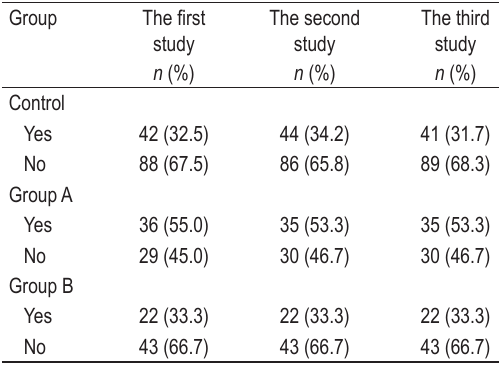
TABLE 10. The presence of anxiety due to possible fall in a